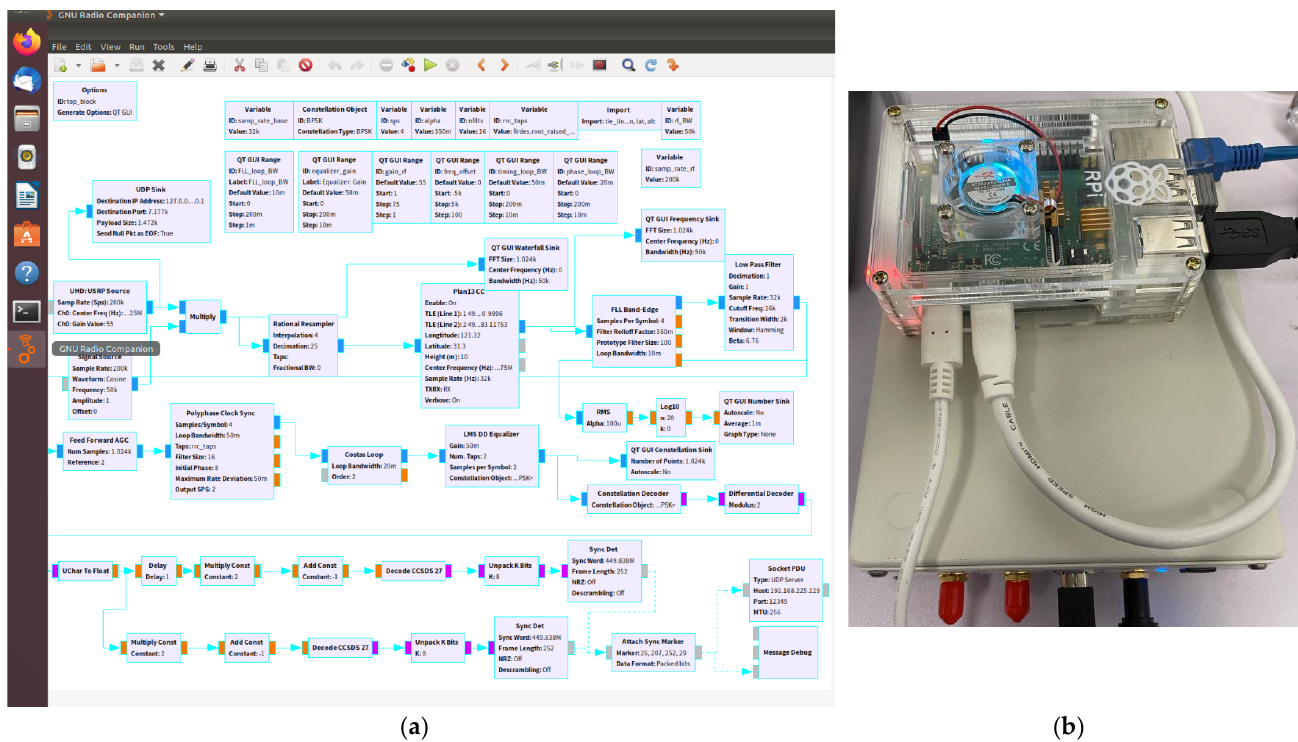
Figure 12. Ground gateway design: ( a ) flow design; ( b ) equipment design.